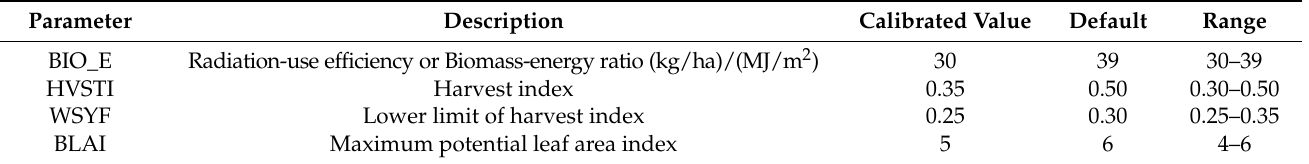
Table 3. SWAT parameters used for the calibration of annual crop yield at Delta Branch Farms in